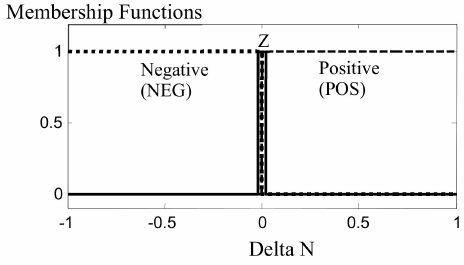
Figure 7. First input membership functions.